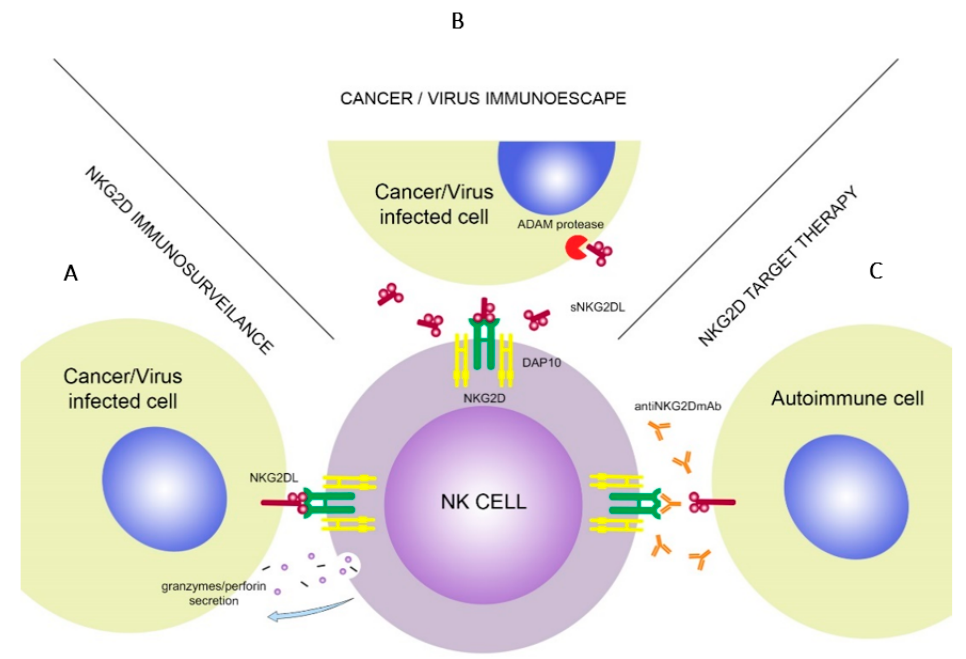
Figure 2. NKG2D association with NKG2DL’s triggers cytokine secretion by the NK cells ( A ). Malignant or virus-infected cells use soluble forms of NKG2DLs to decrease effectiveness of the NKG2D. ADAM protease molecules increase shedding of sNKG2DLs ( B ). In target therapy, NKG2D receptor is blocked by the anti-NKG2D monoclonal antibodies, which prevents it from binding with NKG2DLs ( C ).